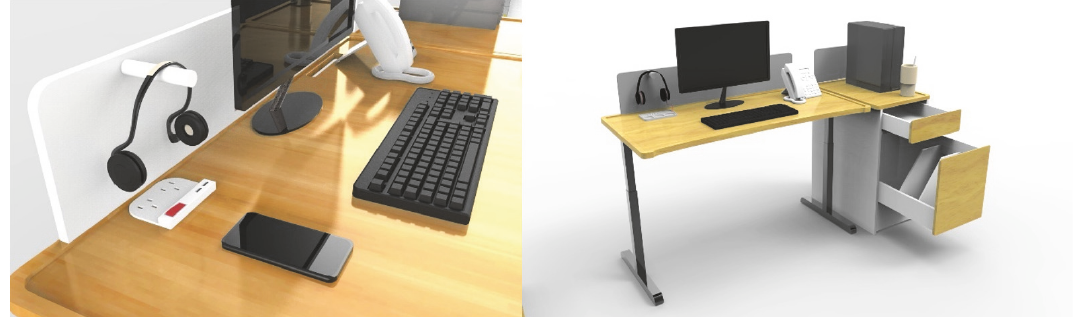
Figure3:Designofguardrailsandbarriers,electricswitches,mobileandequipmentstoragecompartments(forcanesorslates)forthevisually impaired [2]. Source: the current study.